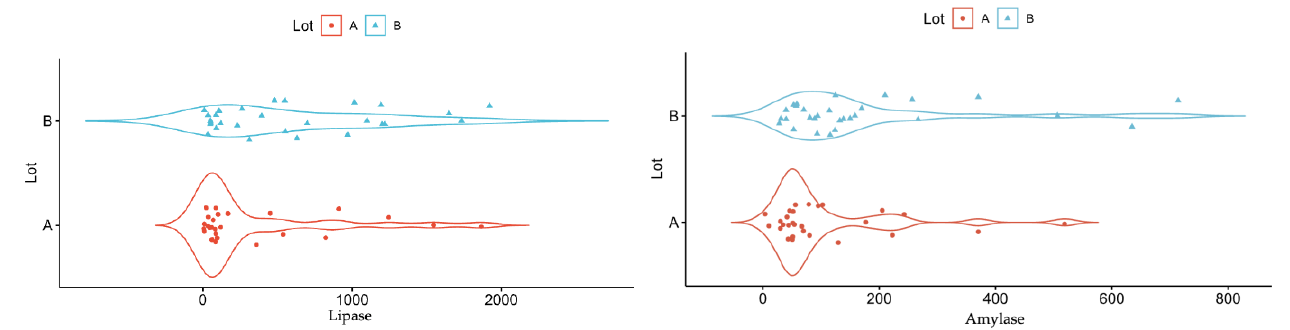
Figure 8. Median values of serum lipase and serum amylase in patients with pancreatic cancer vs. chronic pancreatitis.